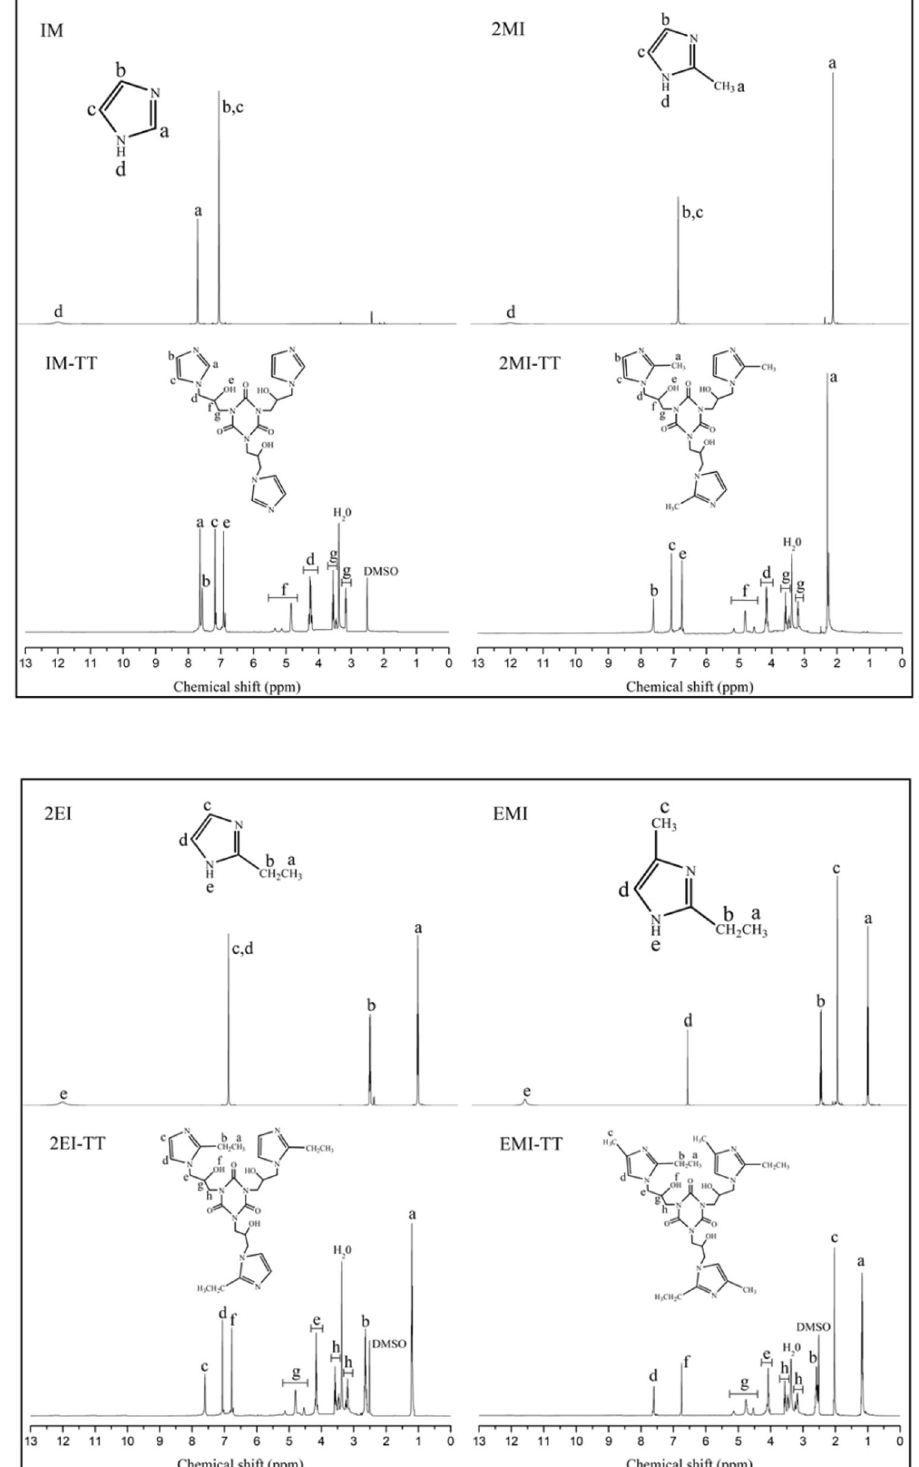
Fig. 2 1 H NMR spectra of IM,